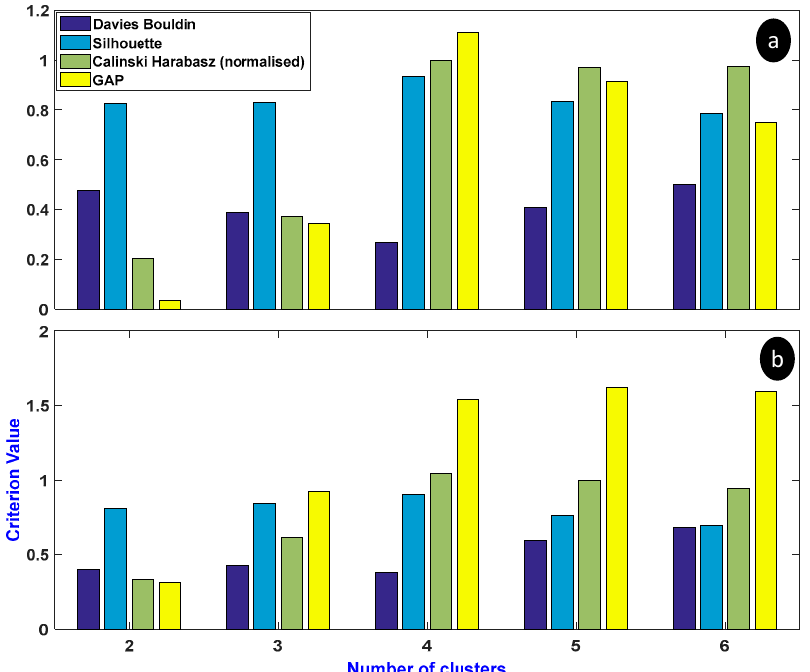
Figure 13. Variation of the criterion of optimal cluster number: ( a ) (RMS, variance) and ( b ) (RMS, mean).